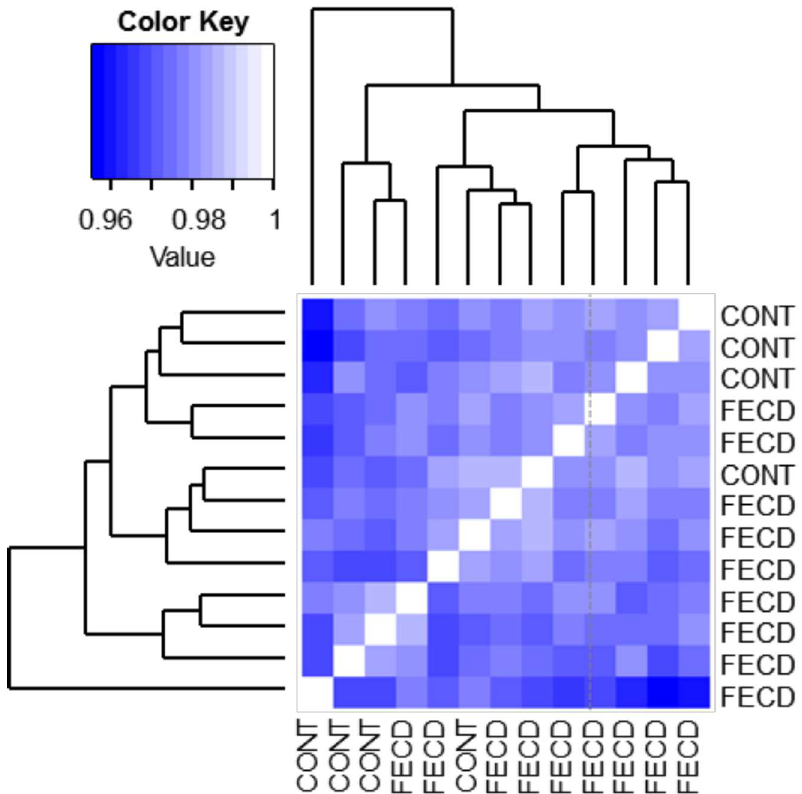
Fig 1. Heatmapvisualization of pairwise Spearman correlation coefficients comparing FECD and control corneal endothelium samples with dendrogram to show clustering (Euclidean distance). Controland FECD samplesseparate accordingto diseasevariable,with the exceptionof one FECD sample.